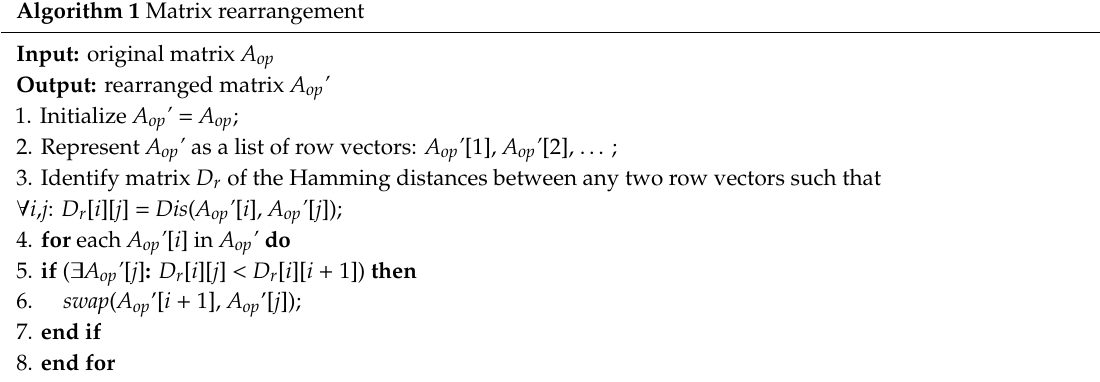
Algorithm 1 Matrix